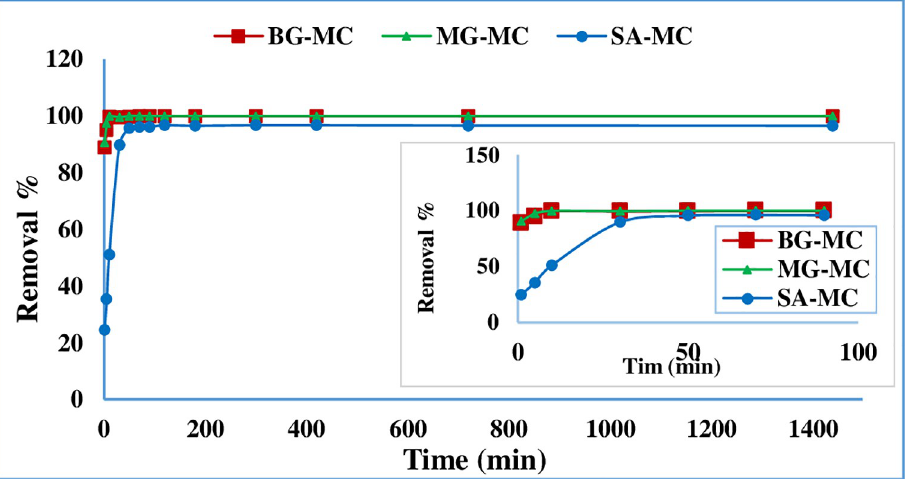
Fig 5. Adsorption time impact of BG, MG, and SA removal onto